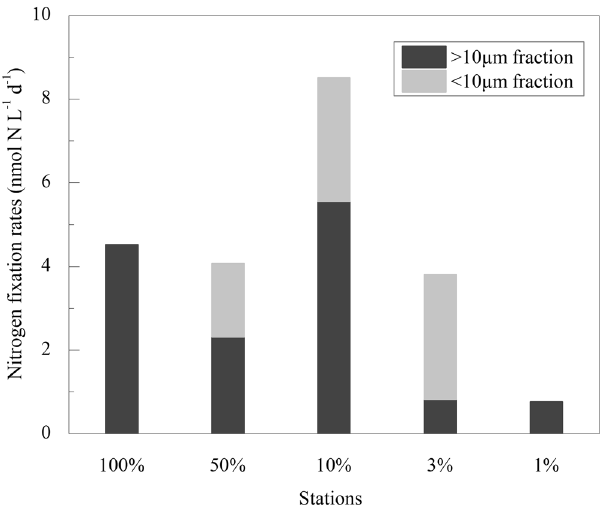
Figure 3. Vertical distribution of N 2 fixation rate at Sta. SEATS. Note for software: Origin 8.5 PRO (http://www. Vertical distribution of the N2 fixation activity.